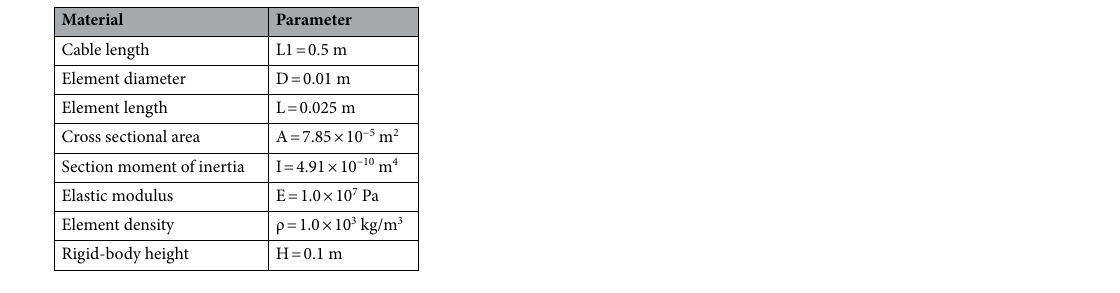
Table 1. Parameters of the model.